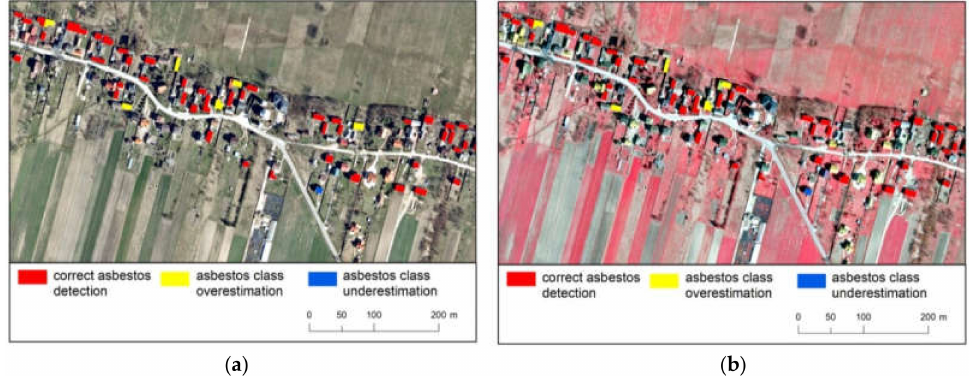
Figure 8. The result of the classification of asbestos–cement roofing in rural part of the commune, Korzecko village: ( a ) RGB composition; ( b ) CIR